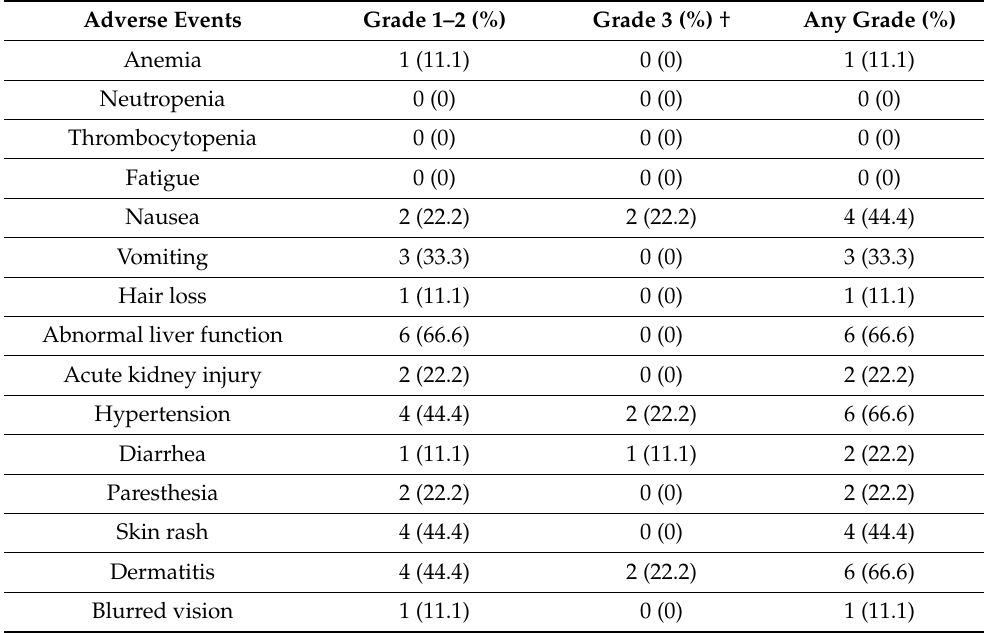
Table 3. Adverse events in all patients receiving triplet therapy for BRAF -mutated